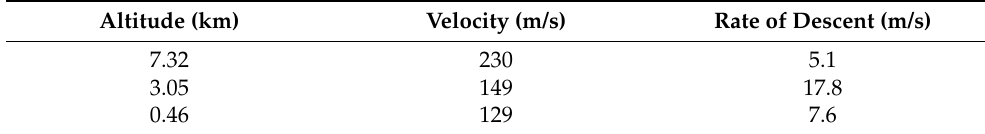
Table 5. A320 descent parameters compiled using data from [43]. Altitude